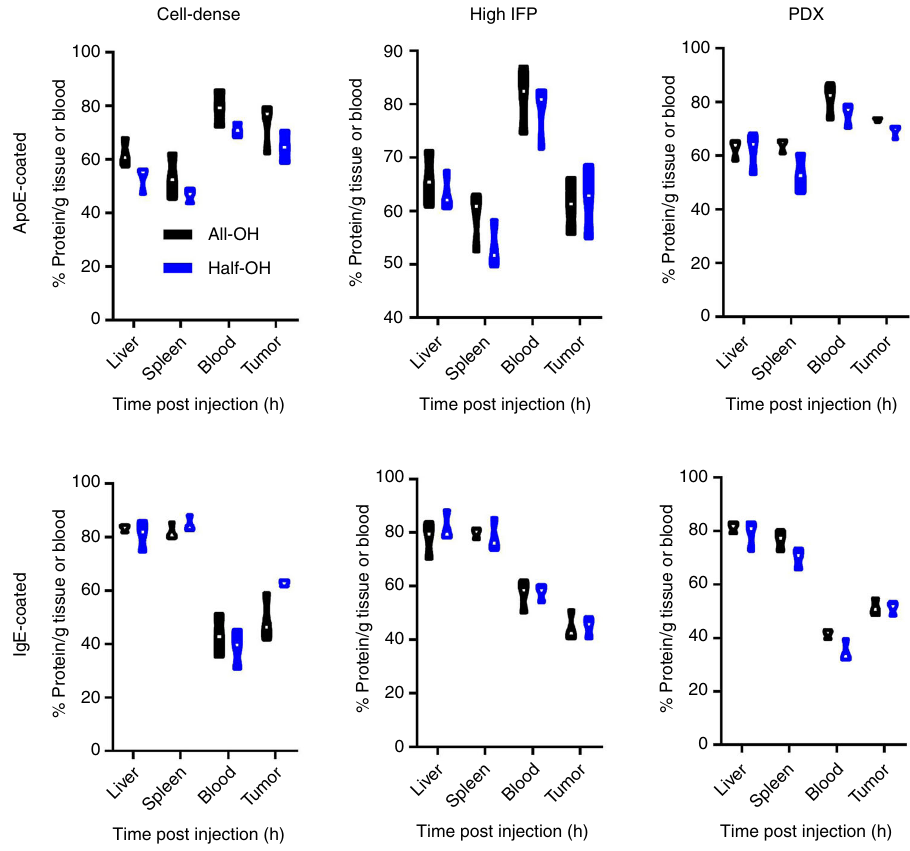
Fig. 9 Loss of original coating proteins. The amount of pre-adsorbed proteins on nanomaterials were quanti fi ed using ICP-MS at 24 h post the administration of G-all/half-OH, with the percentage of remainder capping layer calculated as described in the experimental section. Cell-dense tumor and high IFP stand for the xenograft grown from H22 cells and EMT-6 cells, respectively. The PDX model was established by transplanting the tissue sections harvested from breast cancer-suffering patients into nude mice. Data are presented as mean ± s.e.m. ( n = 3). In the box plot, the upper and lower quartile as outlined by top and bottom boundary were divided by line showing the median